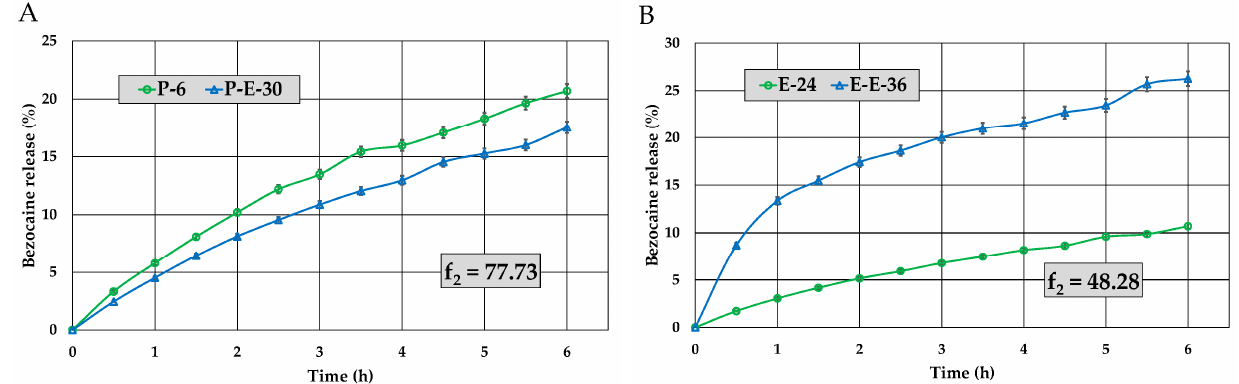
Figure 3. In vitro drug release profiles of four benzocaine semi-solid ointments: ( A ) formulations P-6, P-E-30, ( B ) formulations E-24, E-E-36. Mean ± SD, n = 6.